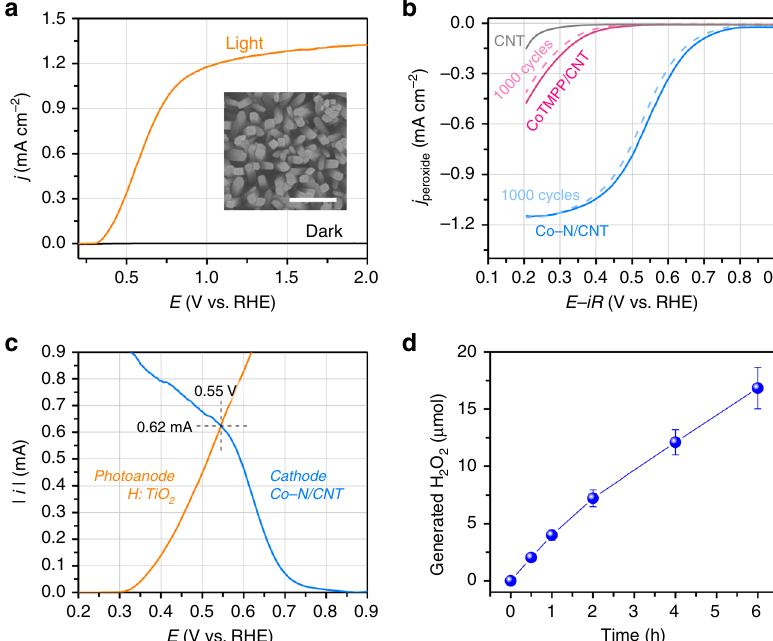
Fig. 2 Photo-electrocatalytic production of H 2 O 2 in the three-compartment reactor. a Photocurrent density of the H:TiO 2 electrode under illumination (orange line) and in the dark (black line) in 0.1 M phosphate borate solution at pH 4.5. Inset: SEM image of H:TiO 2 . Sacle bar is 1 µ m. b Linear sweep voltammetry (LSV) curves of Co – N/CNT (sky blue), CoTMPP/CNT (pink), and CNT (grey) catalysts before (solid line) and after (dashed line) potential cycling tests. The current densities for H 2 O 2 production are shown and were obtained via rotating ring disk electrode measurements at an electrode rotation speed of 1,600 rpm in O 2 -saturated 0.1 M phosphate borate solution at pH 4.5. c LSV curves of H:TiO 2 photoanode (orange line) under simulated 1 sun (AM1.5 G) illumination in 0.1 M phosphate borate solution at pH 4.5 and LSV curves of Co – N/CNT cathode (sky blue line) in O 2 -saturated 0.1 M phosphate borate solution at pH 4.5. d Amount of H 2 O 2 generated over time in 0.1 M phosphate borate solution at pH 4.5 during the operation of the integrated three-compartment reactor. Error bars indicate the standard